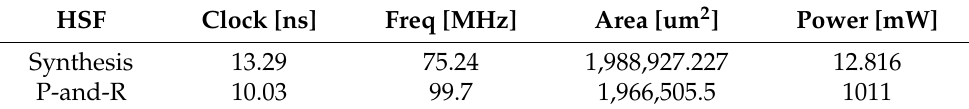
Table 2. Area, Timing and Power results for the Wiener filter ASIC implementation.